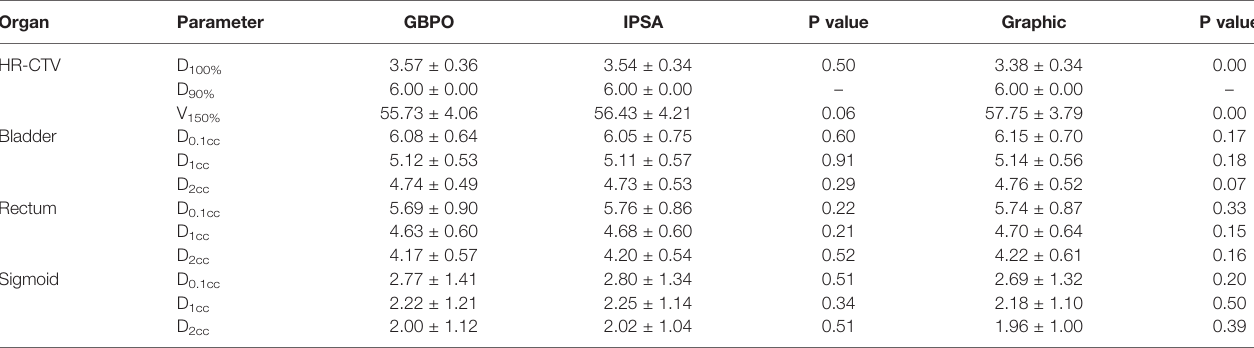
TABLE 2 | A dosimetric comparison for target and organs at risk. Organ Parameter GBPO IPSA P value Graphic P value